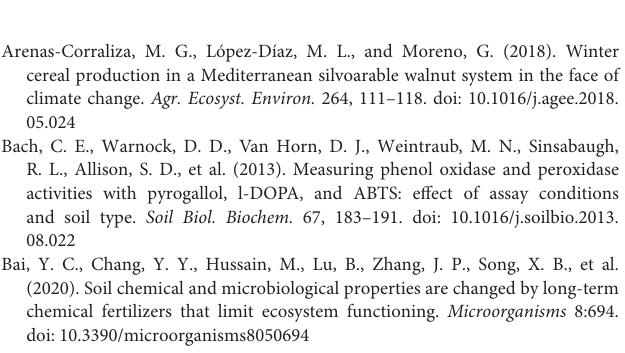
Supplementary Figure 2 | Heat map showing relative abundances of the significantly enriched fungal OTUs found in the (A) walnut-tea intercropping